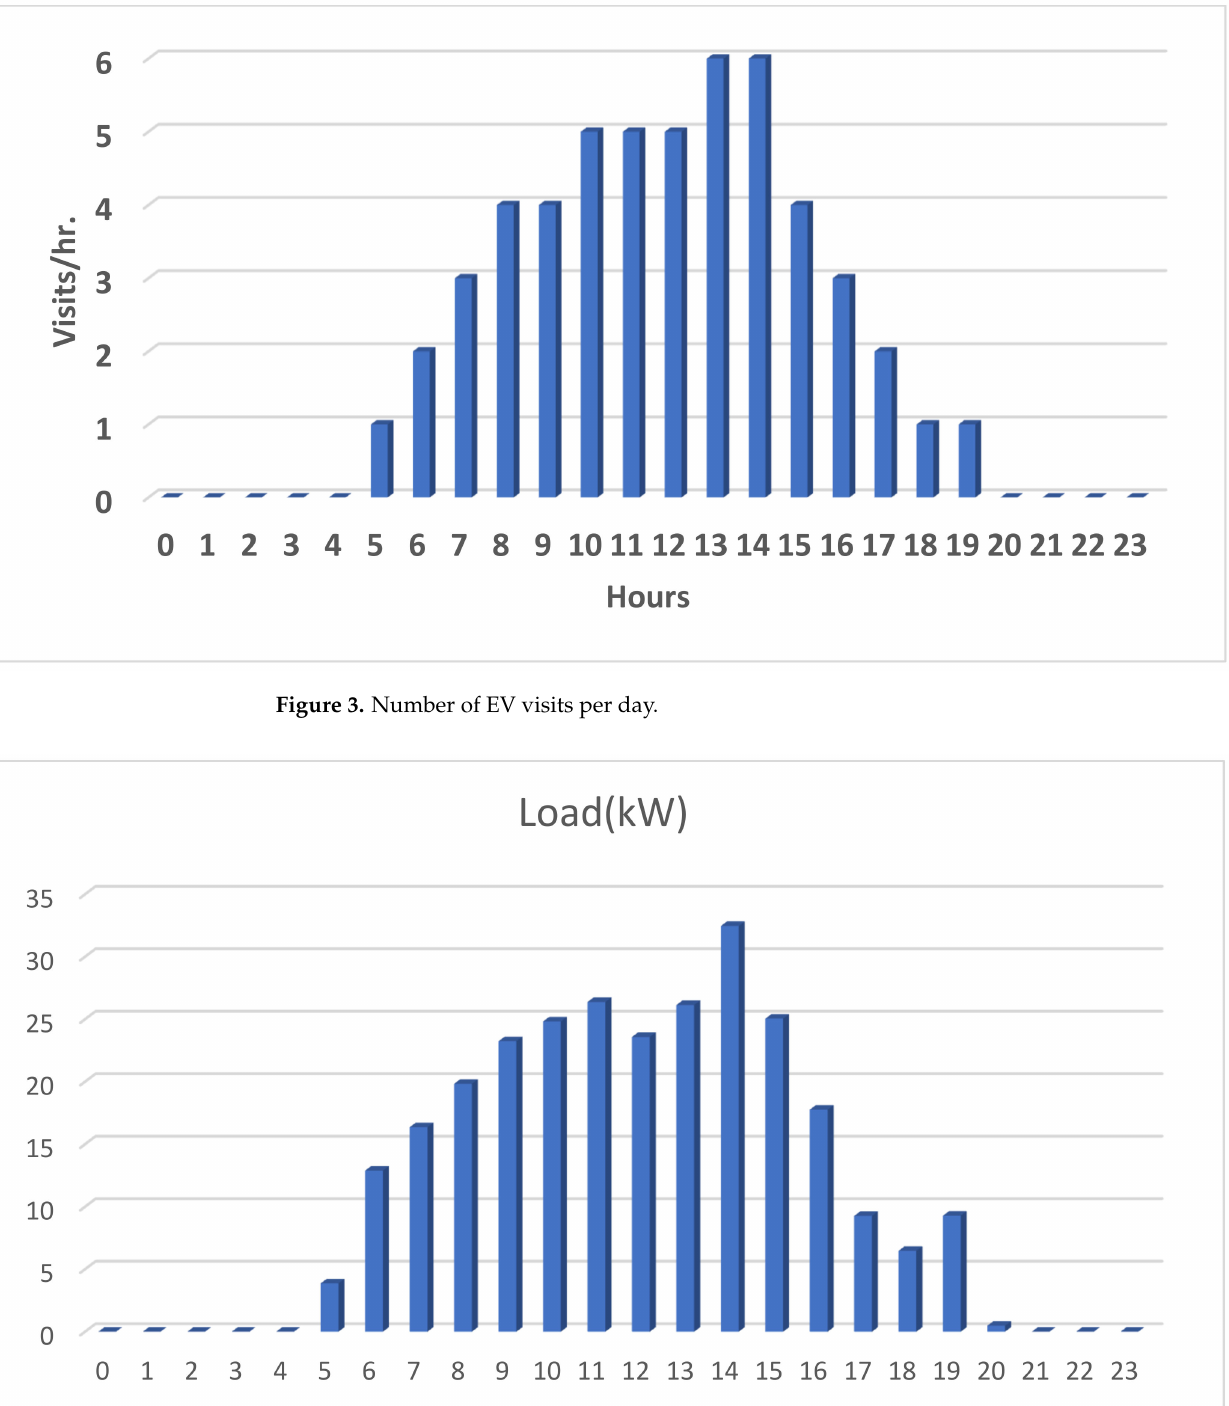
Figure 4. The daily load profile of the EV charging